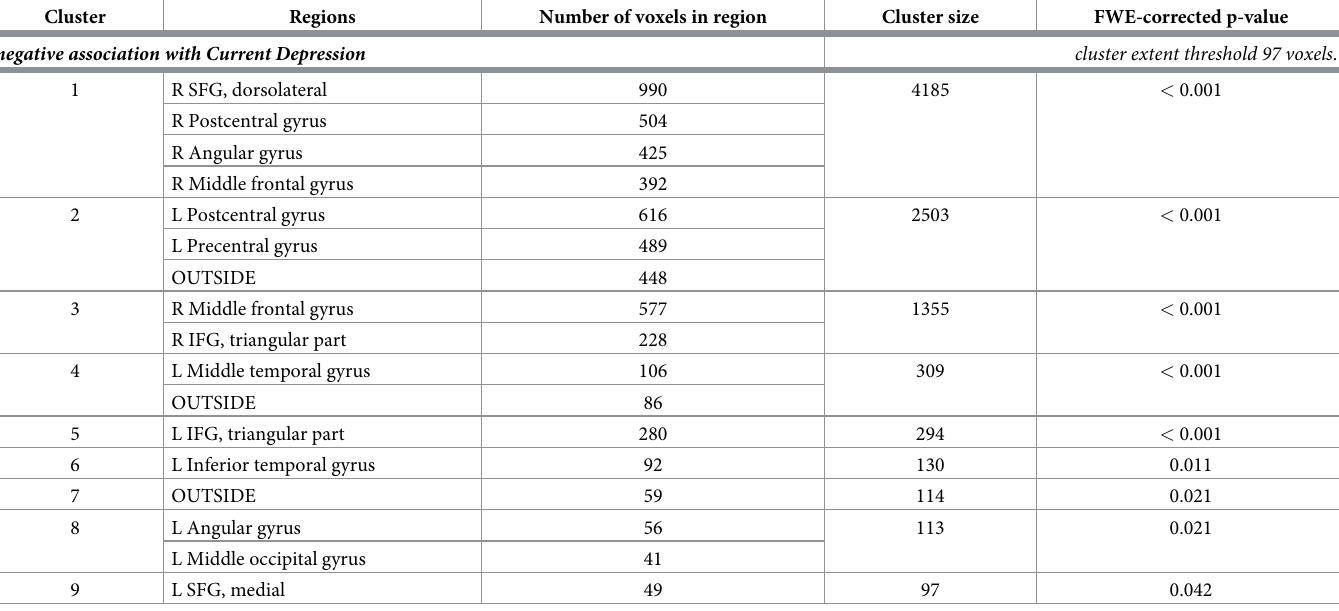
Table 4. Model of current and past depressive disorders. Brain regions showing differences in maternal activation to own infant in positive versus negative emotion tasks (InfOwnPos > InfOwnNeg) related to current diagnosis of depression.